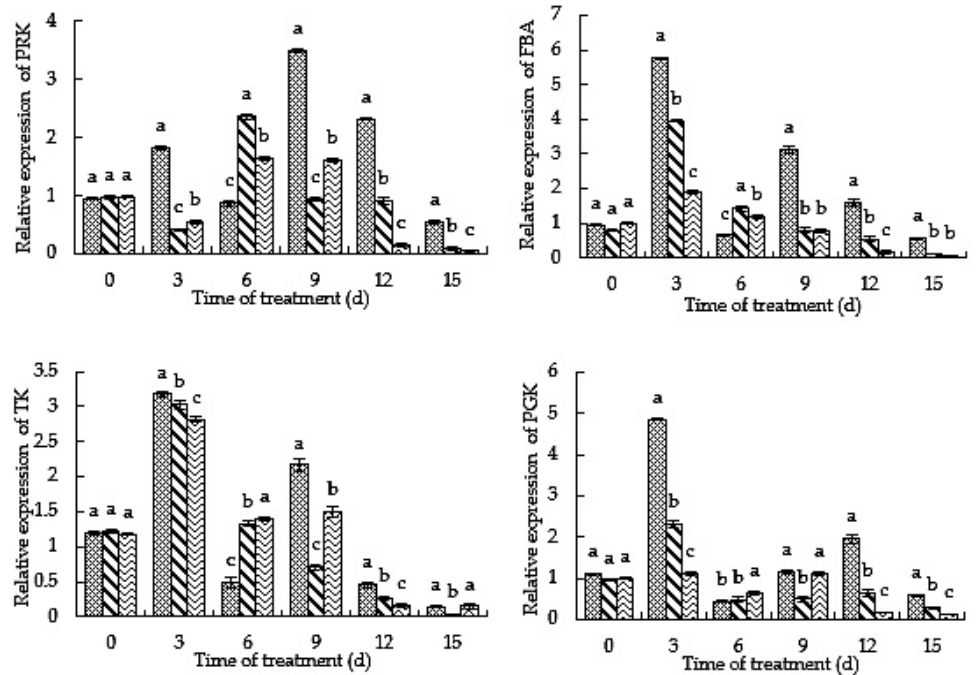
Figure 9. High root-zone CO 2 affects the expressions of carbon assimilation-related enzyme genes in oriental melon. Standard errors (SEs) of the means are represented by error bars. Different letters in the same row indicate significance at the 0.05 level among treatments.